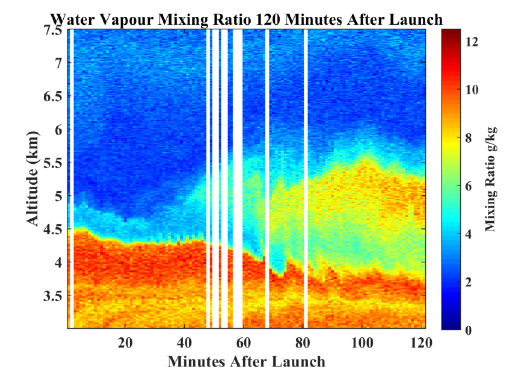
Figure 4: Lidar water vapour mixing ratio after RS92 launch. The white lines are scans that were filtered by the vetting procedure prior to